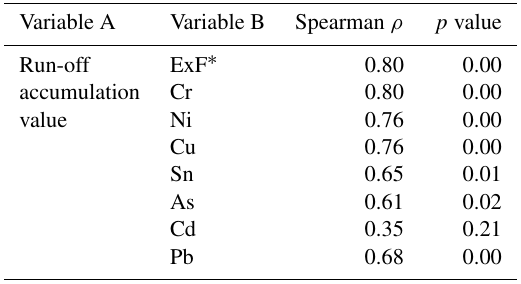
Table 4. Spearman correlation between run-off accumulation value, exposure factor (ExF) and metal concentrations for sampling points at sites significant height differences (sites – AM, FV, and MP). Variable A Variable B Spearman ρ